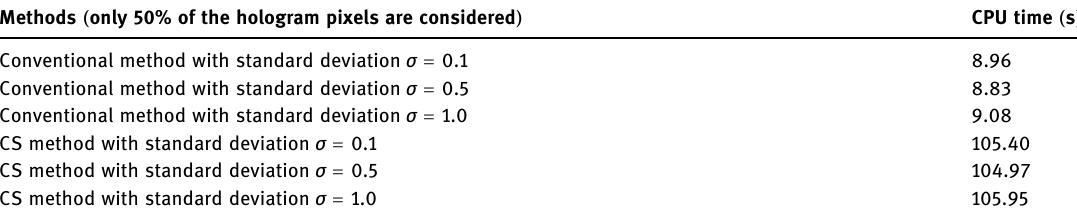
Table 2: CPU time for the complex object wave reconstruction using GPSR algorithm Methods ( only 50% of the hologram pixels are considered ) CPU time ( s ) Conventional method with standard deviation = σ 0.1 Conventional method with standard deviation = σ 0.5 Conventional method with standard deviation = σ